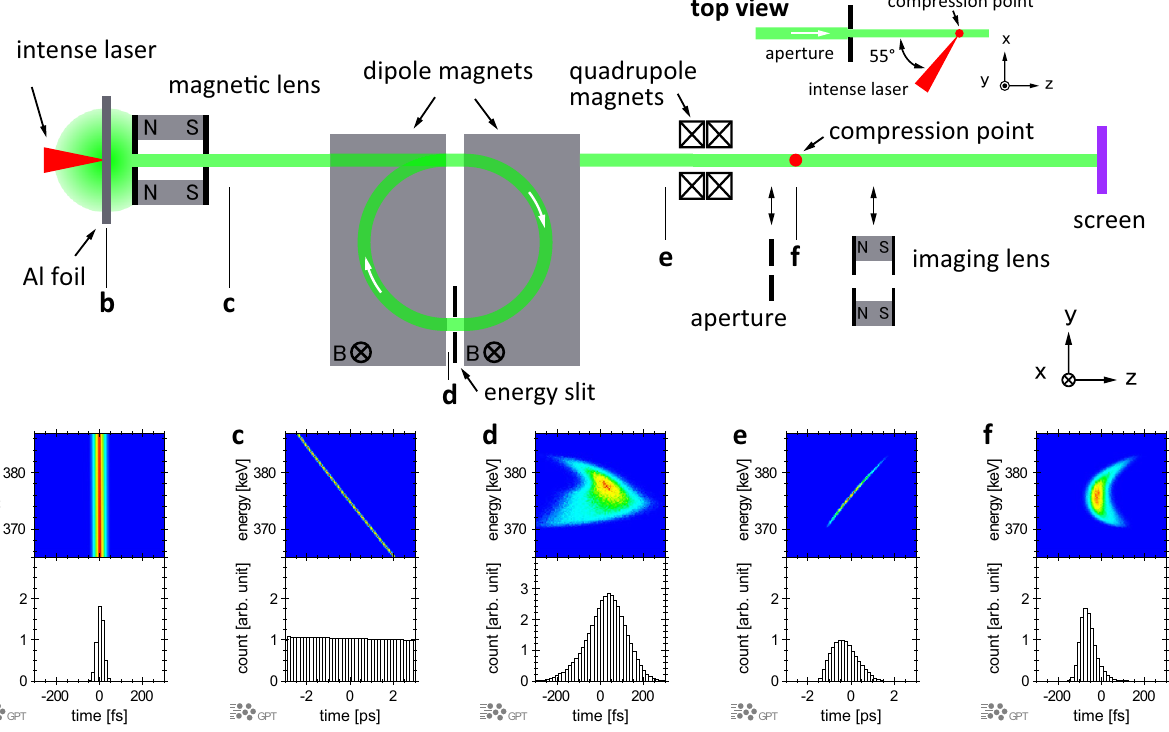
Figure 1. Schematic of experimental setup and simulated temporal characteristics of an electron pulse. ( a ) Schematic of experimental setup for electron pulse acceleration, compression, timing measurements, and pulse width measurements. ( b – f ) Simulated longitudinal phase space and histograms for the electrons at each of the positions indicated in ( a ). The initial electron pulse width was assumed to be 40 fs at FWHM and the energy distribution was set to a uniform width of 375 ± 15 keV ( b ). A portion of the electrons passing through the magnetic lens was collimated and automatically chirped with their energy spread ( c ). The collimated electrons were injected into a dipole-type phase rotator to rotate their momentum distribution in longitudinal phase space. The phase space and histogram just after the energy slit of the rotator ( d ), prior to the quadrupole magnets ( e ), and at the compression point ( f ) are also